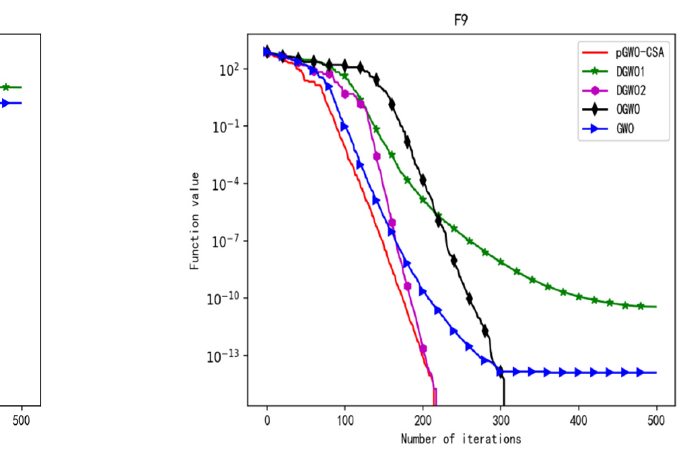
Figure 27. Convergence curve of test function F8.